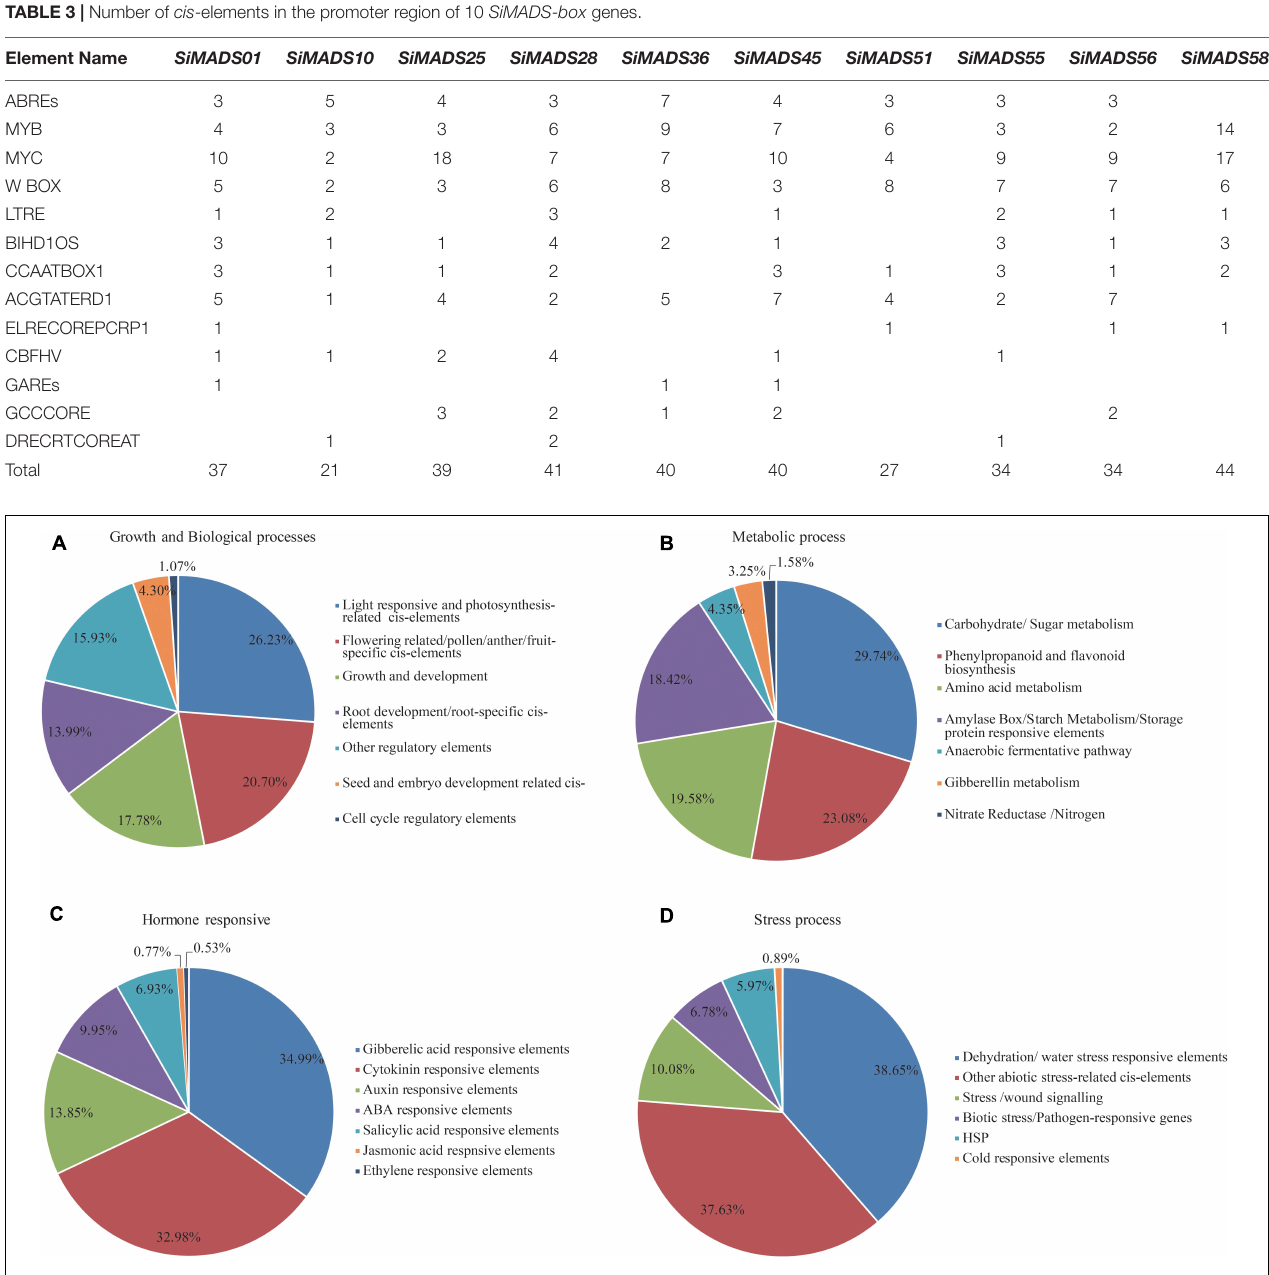
FIGURE 4 | Percentage distribution of cis-regulator elements (CREs) in the promoters of SiMADS-box genes based upon the putative functions. (A) Growth and biological process responsive elements. (B) Metabolism responsive elements. (C) Stress responsive elements. (D) Hormone responsive elements.